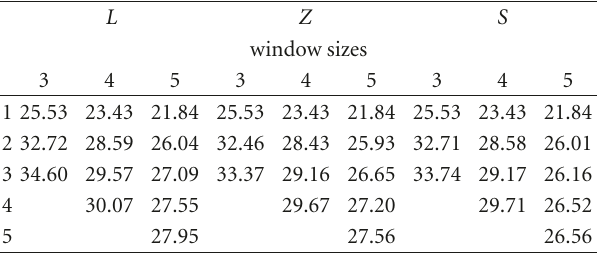
Table 2: Signal to noise ratio (dB) for one-dimensional FMP. L